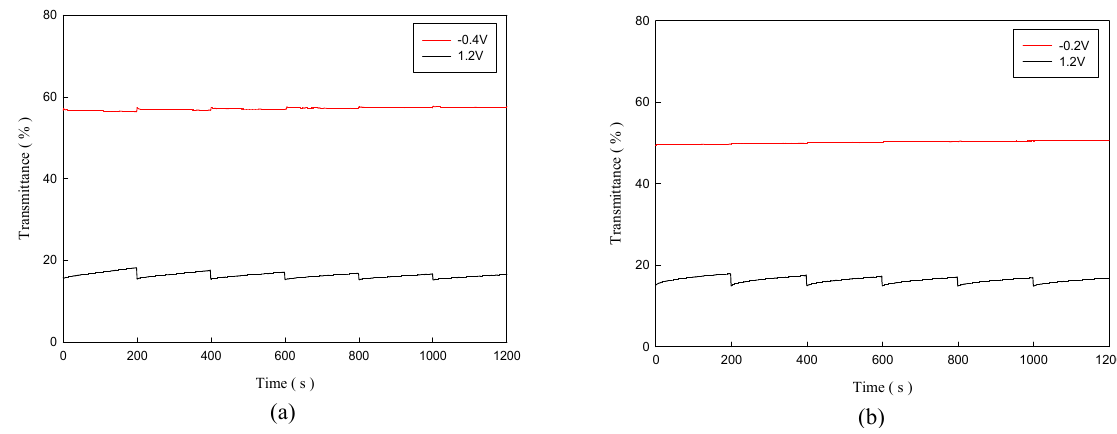
Figure 10. Open circuit stability of the: ( a ) P(TTPA- co -DIT)-1.0 V/PProDOT-Et 2 ECD monitored at 590 nm; and ( b ) P(TTPA- co -BDTA)-1.0 V/PProDOT-Et 2 ECD monitored at 588 nm.